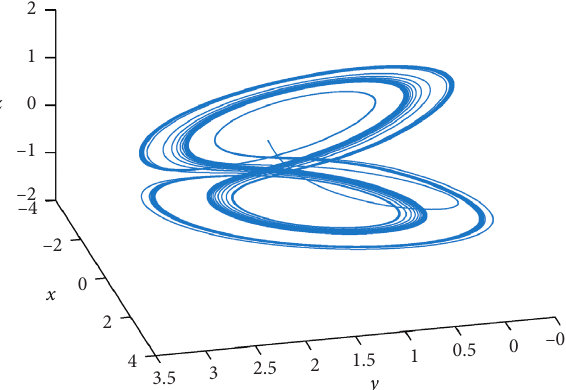
Figure 1: Dynamic behavior of fractional financial chaotic model with α � 0 . 95.